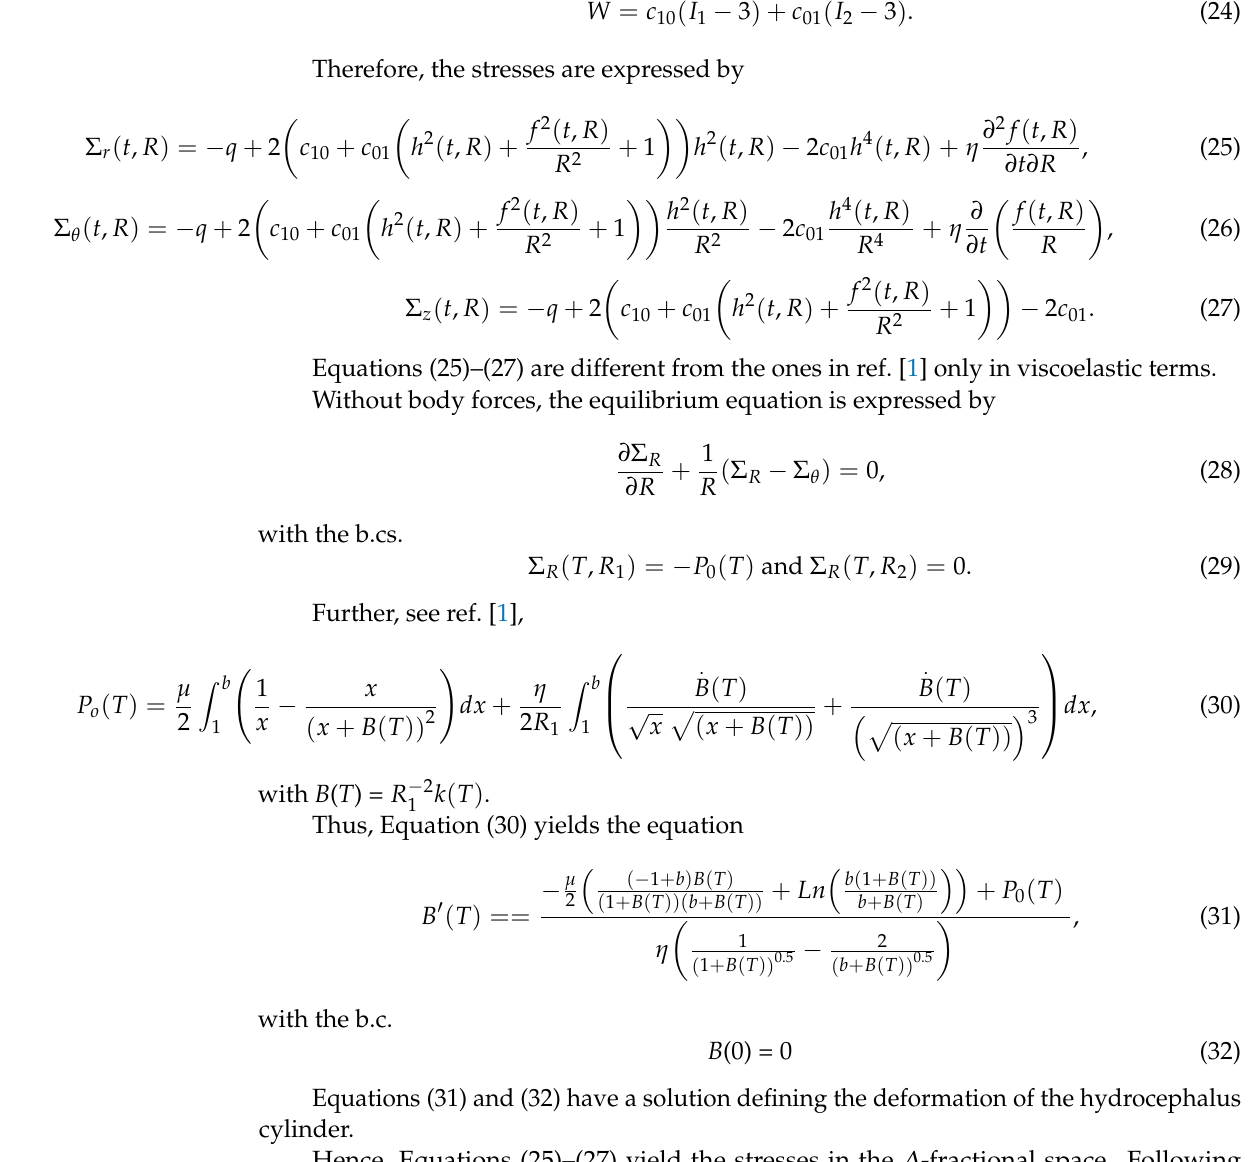
Figure 3. The stress Σ θ ( T , R ) in the Λ -fractional space. It is evident that the assumptions influence the fluid flow through the deformation of the hydrocephalus cylindrical tube.